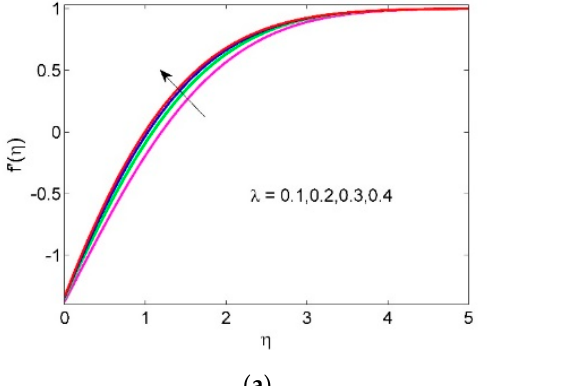
Figure 2. Impacts of Sb on 𝑓 ′ (𝜂) , 𝜃(𝜂) and 𝜙(𝜂) . Figure 3a demonstrates that by rising values of the curvature parameter ( λ ), the ve- locity profile intensifies slightly. The radius of the cylinder is inversely proportional to the curvature parameter by definition, a rise in the λ implies a decrease in the cylinder radius. The profile of temperature declines due to increasing λ . As the increase in λ , the flatness of the shrinking surface rises, consequently, the flow velocity accelerates, and the profile of temperature decreases because the resistance between the fluid layer reduces (see Fig- ure 3b).